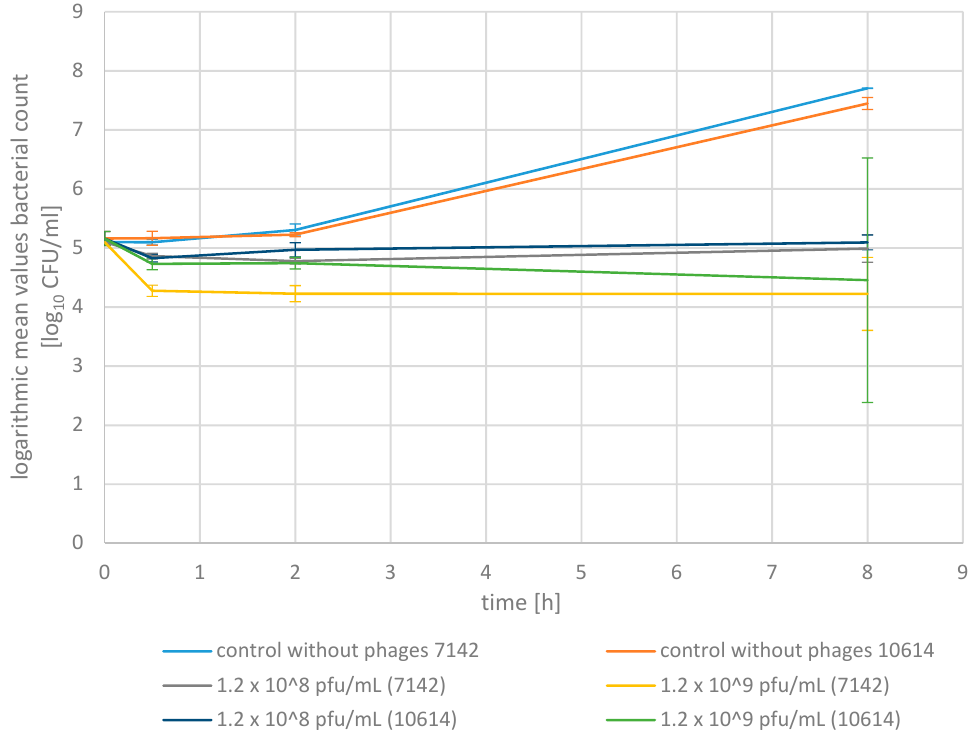
Figure 4. Bactericidal activity of a phage mixture in raw milk with standard deviations. The mean germ density (log 10 cfu / mL) of the two S. aureus isolates 7142 and 10,614, respectively, for the control culture without phages (blue: 7142; orange: 10,614), the assays with the addition of 0.1 mL phage mixture at a final concentration of 1.2 × 10 8 pfu / mL (grey: 7142; violet:10614) and 1 mL phage mixture at a final concentration of 1.2 × 10 9 pfu / mL (yellow: 7142; green: 10614). Inoculation with S. aureus at a concentration of averagely 1.4 × 10 5 cfu /